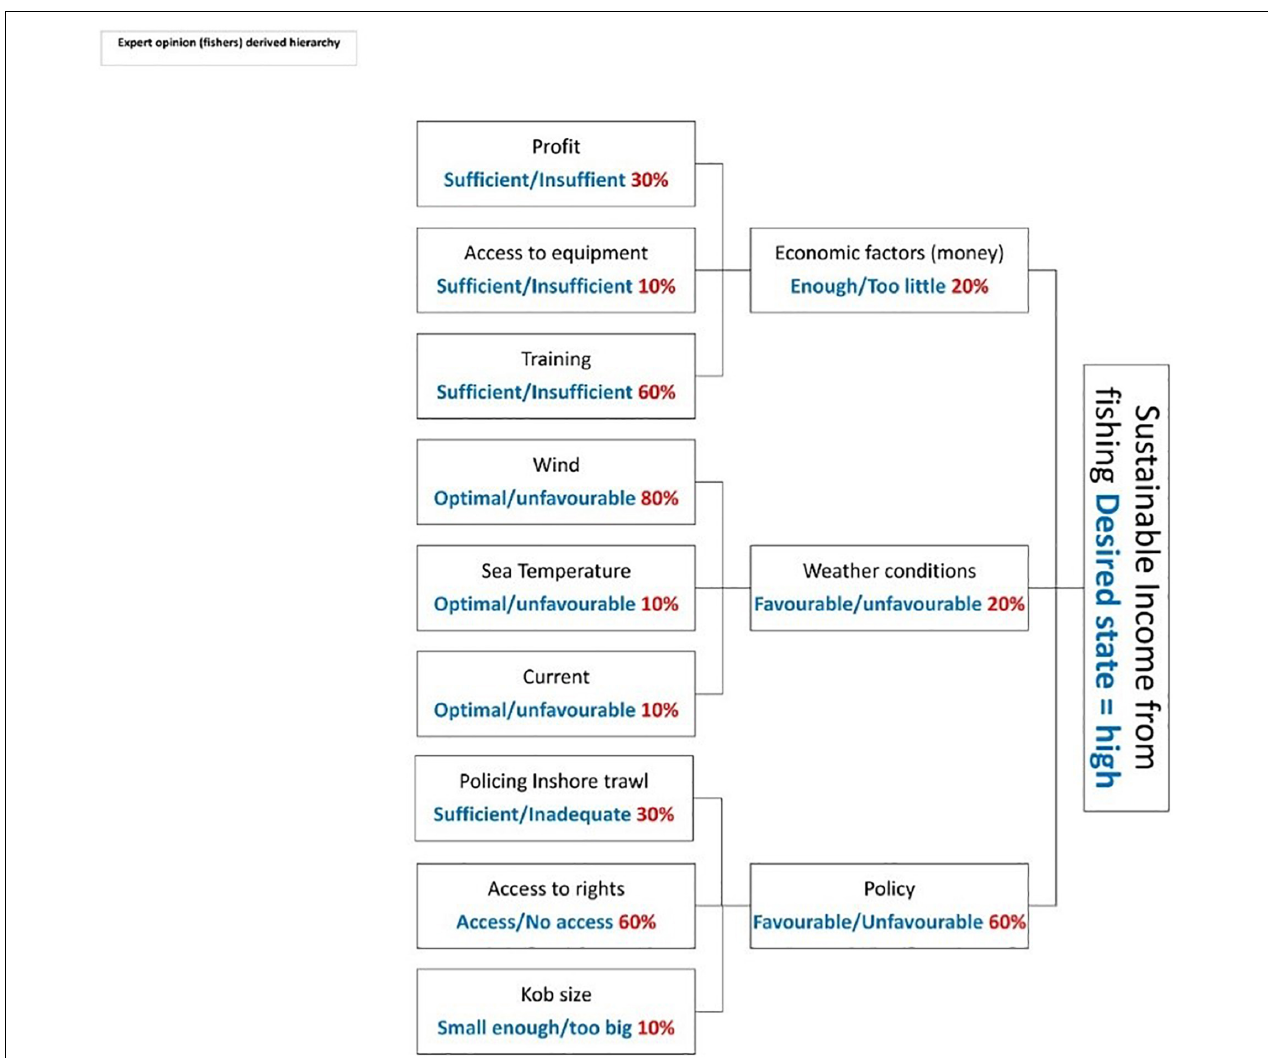
FIGURE 5 | Weighted hierarchy, showing states and associated weightings, derived from fisher’s inputs in Workshop One. The desired outcome is a sustainable fishery-derived income (high/low). Drivers at the first hierarchy are ‘Policy (and regulation)’, ‘Weather conditions’ and ‘Economic factors (money)’. At the second hierarchical level, the size of the kob (fishers are permitted to catch) (Access to) fishing rights and policing of the Inshore trawl inform the ‘Policy’ driver. Wind, Current and sea temperature inform the ‘Weather conditions’ driver while (skipper) training, access to equipment and profit (margin) informs the ‘Economics’